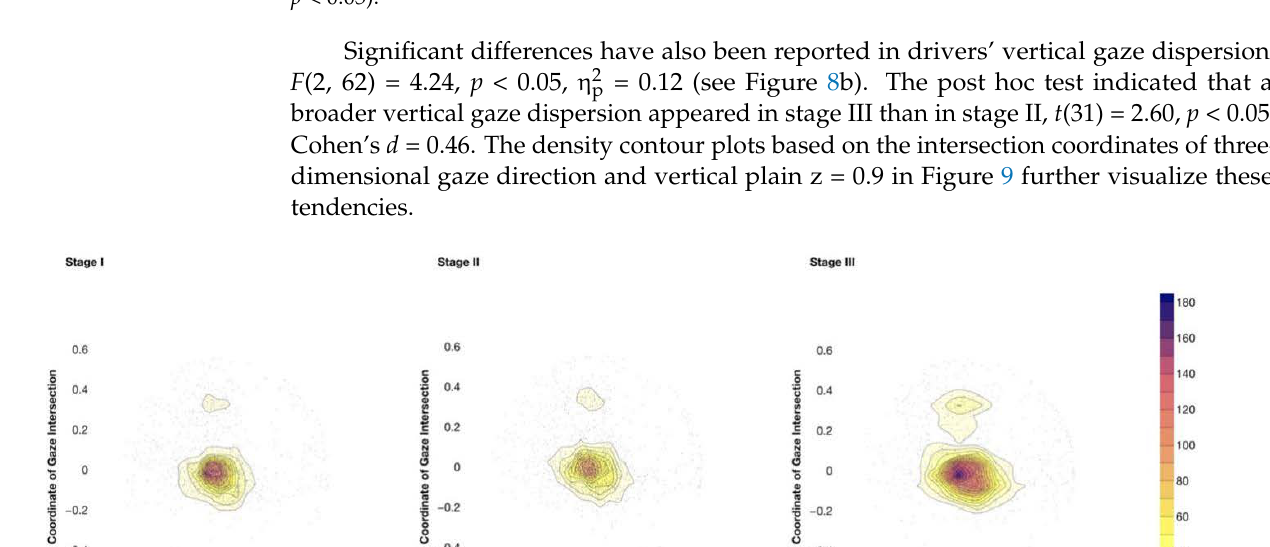
Figure 9. Visualization of horizontal and vertical gaze dispersions under three driving stages.